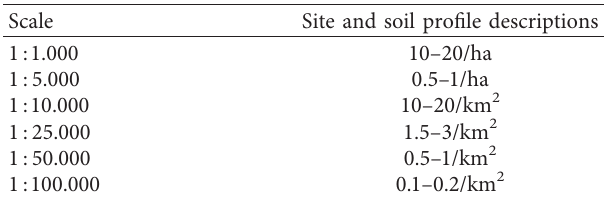
Table 2: Recommended intensities of soil investigation.